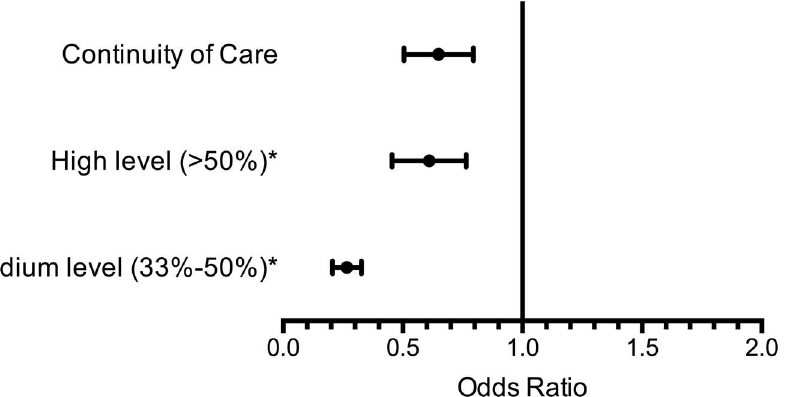
Figure 2. Adjusted Odds Ratio of Association Between ED Visit and Continuity of Care and Levels of Continuity. The first row illustrates the adjusted odds ratio between ED visits and continuity of care for individuals with at least one visit having continuity with their primary care provider. The second and third rows are the adjusted odds ratio for individuals who had high and medium levels of continuity and are compared to individuals with low levels of continuity, indicated by the asterisk